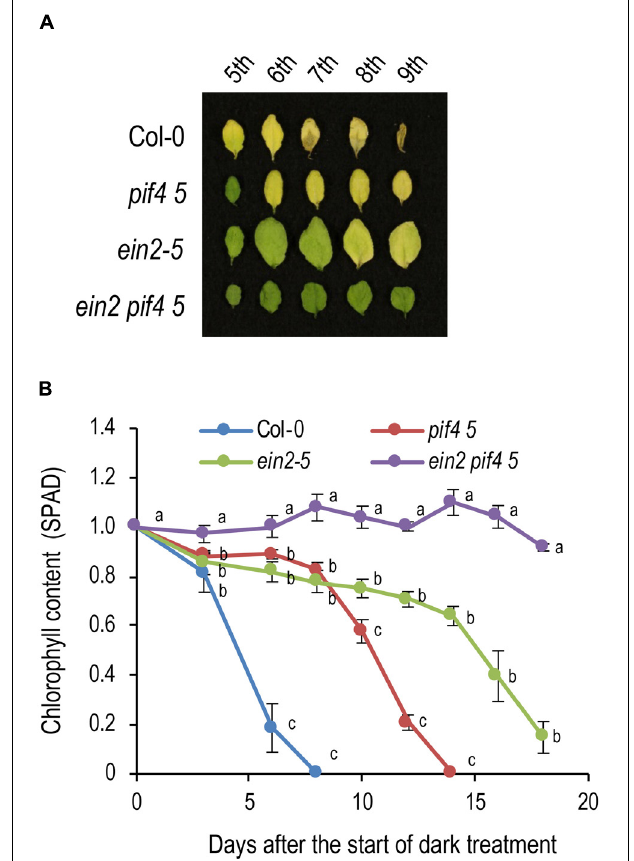
FIGURE 4 | Genetic interaction between EIN2 and PIF4/PIF5 in dark-induced senescence. (A) Delayed leaf senescence phenotype of the ein2 pif4 pif5 triple mutant. Leaves in the 5th to 9th positions from the top of 4-week-old plants were incubated in the dark for 14 days. (B) Changes in chlorophyll content (SPAD value) over time in the ein2 pif4 pif5 triple mutant during dark incubation. Detached 7th position leaves were used for the analysis. Data for the same day after the start of dark incubation were statistically compared using Tukey’s multiple comparison method ( p < 0.05). Bars indicate standard errors ( n =